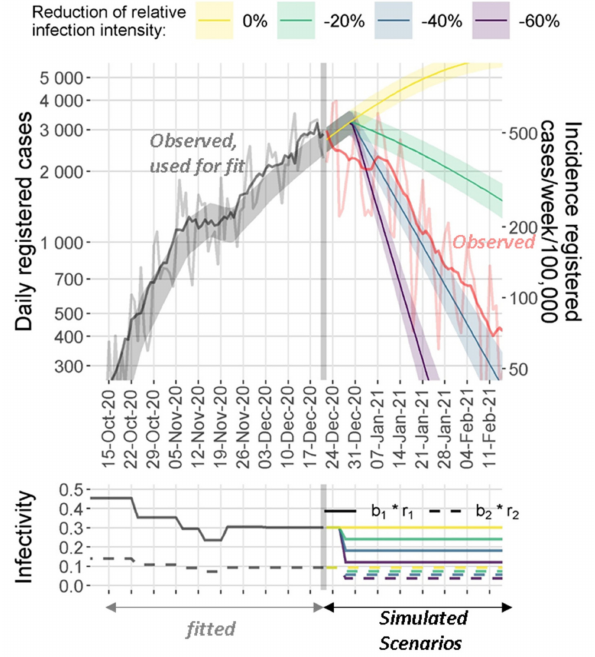
Figure 6. Comparison of predicted and observed decline of the second wave in Saxony according to the initiated lock-down. Our model was used to fit the observed data until 21 December 2020 (shown as grey curve (raw data) and black curve (smoothed) of reported test-positives). Estimated step functions b 1 and b 2 describing the infectivity of asymptomatic and symptomatic subjects were reduced by 0% (yellow: no lock-down = control scenario), 20% (green: pessimistic scenario), 40% (blue: realistic scenario), and 60% (magenta: optimistic scenario) to simulate four scenarios of the future course of the epidemic under lock-down conditions. The observed numbers of test-positives after the 21 December 2020 are shown in red (light red = raw data, dark red = smoothed) closely followed the expected scenario of 40% lock-down efficacy. Shaded areas represent 95% prediction intervals. The predictions and parameters were reported in our regular bulletin deposited at Leipzig Health Atlas, ID: 85AH9JMUFM-4.